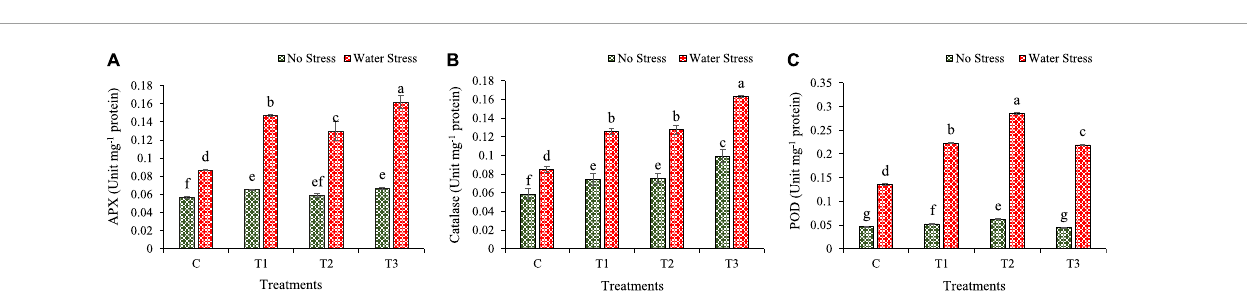
comparison to plants without bacterial treatment under water stress